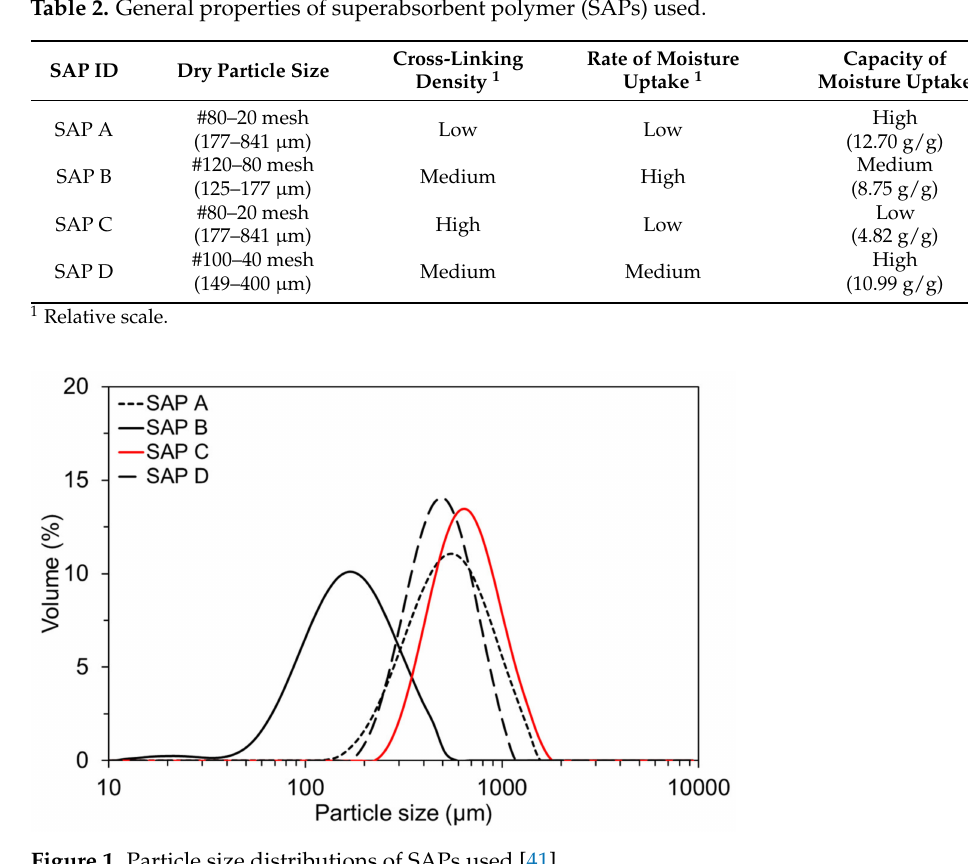
Figure 1. Particle size distributions of SAPs used